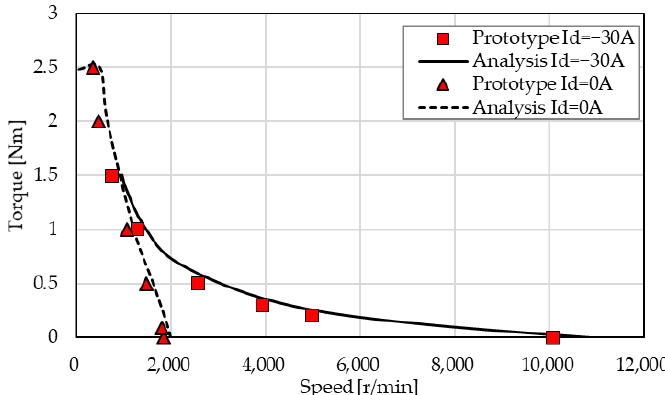
Figure 23. N-T characteristics of analysis model and prototype motor at I d = 0 A, − 30 A.